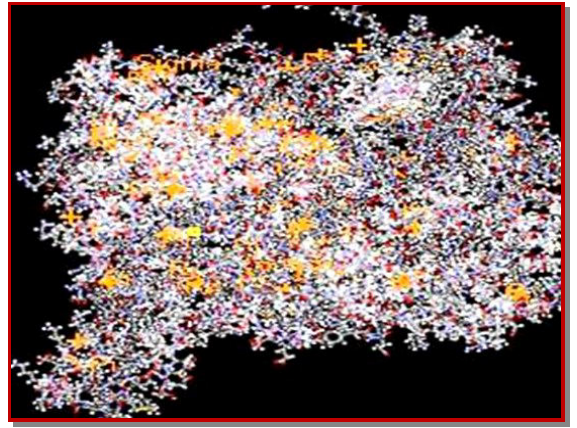
Figure 1: Xanthine oxidase from bovine milk source